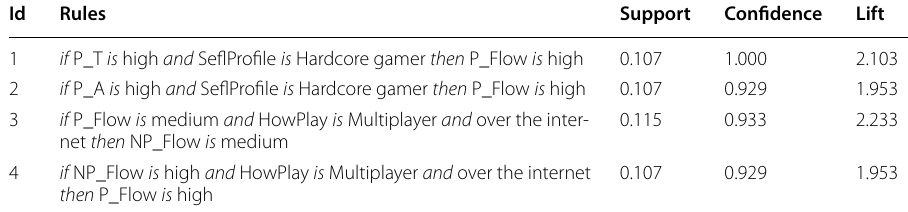
Table 7 Player profile related